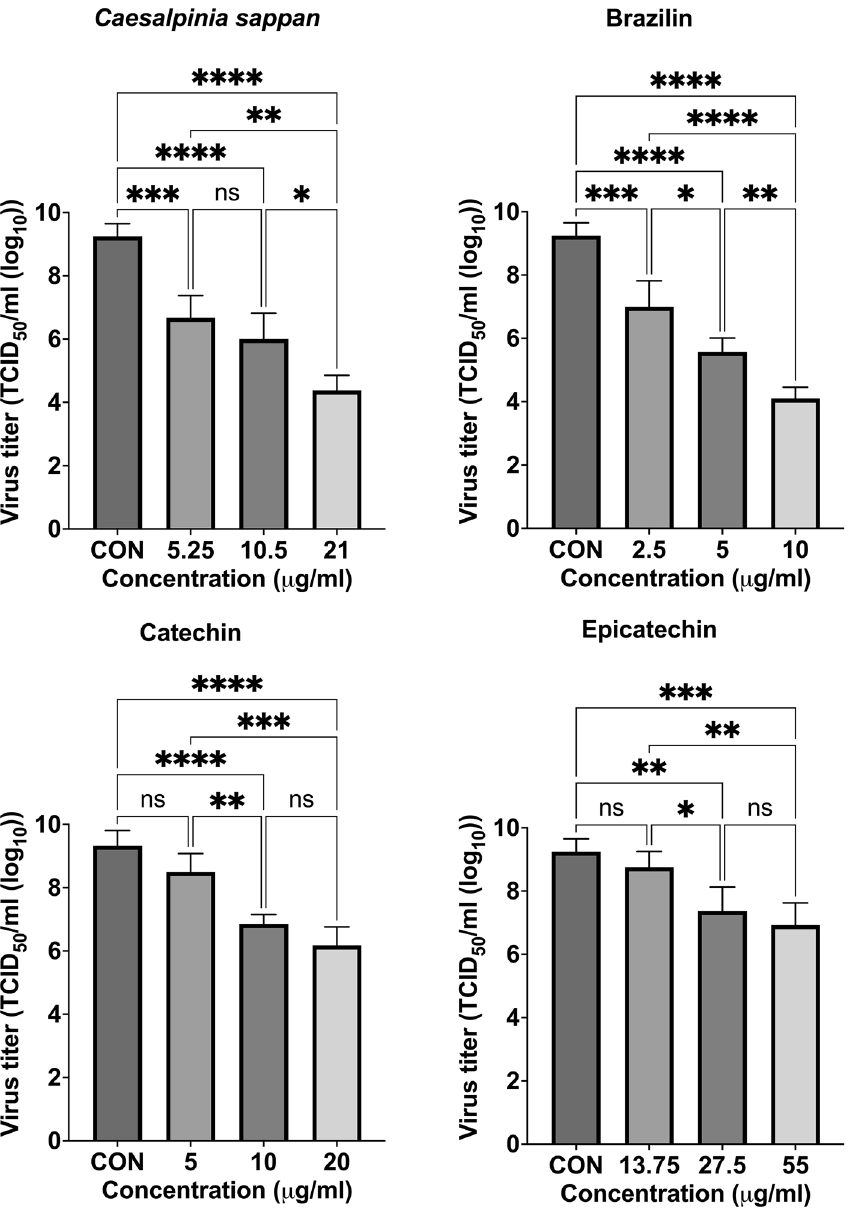
Figure 7. Virus titer of Caesalpinia sappan extract, brazilin, catechin, and epicatechin on inhibition of viral infection against PRRSV in MARC-145 cells as measured by IPMA assay. MARC-145 cells were treated with Caesalpinia sappan extract, brazilin, catechin, and epicatechin for 1 h, then inoculated with PRRSV (MOI = 1). The data (mean ± SD) are indicative of four independent replicates. To compare the means of samples with differing concentrations, Tukey’s test was used to assess statistical significance. CON, control; ns, not significant; * P < 0.05; ** P < 0.01; *** P < 0.001; **** P <